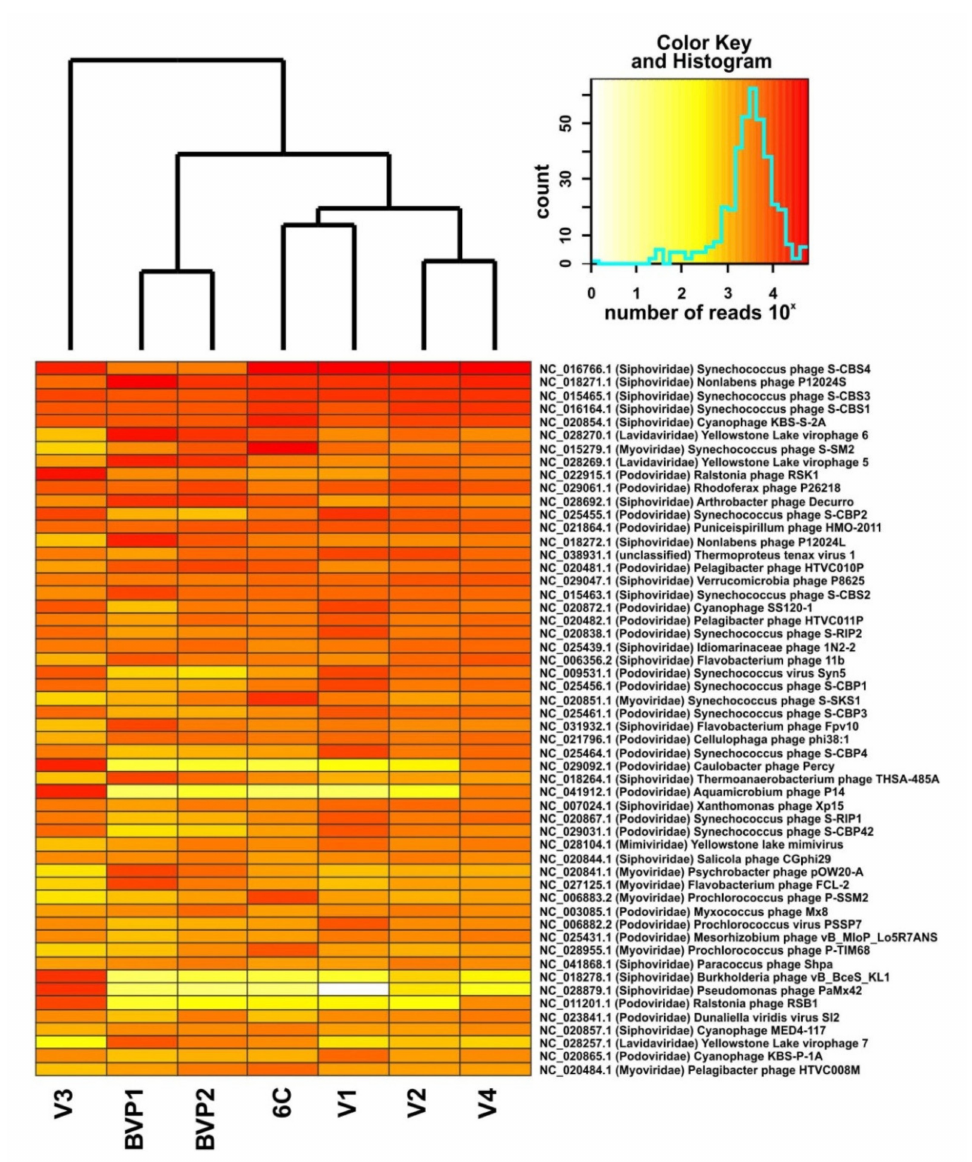
Figure 2. Heat map of the occurrence of the first 54 dominant virotypes comprising 50% of all sequences in the Baikal viromes. The list of published datasets is shown in Table 2. Read counts of virotypes are shown in log10